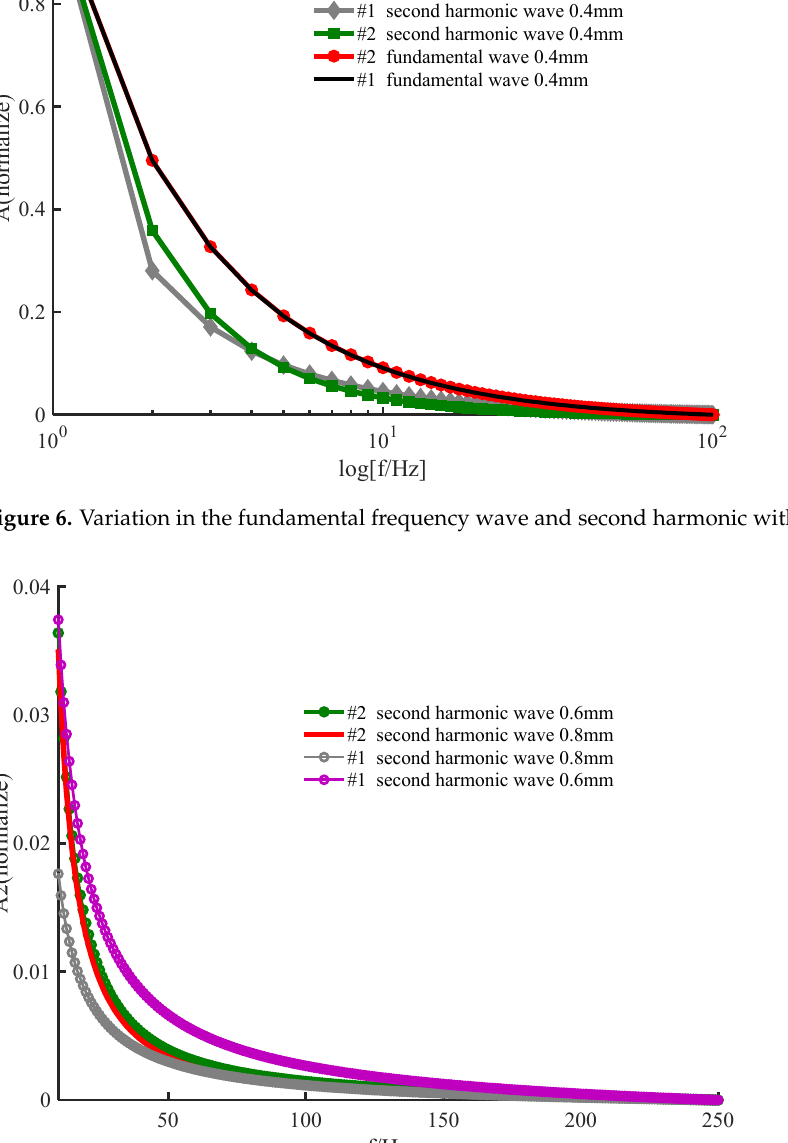
Figure 7. Variation in the second harmonic with frequency for different sample thicknesses.